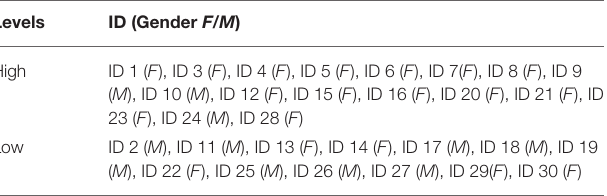
TABLE 1 | Pragmatic performance levels of participants.